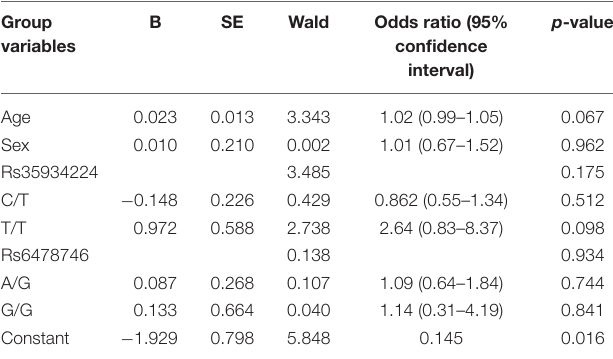
TABLE 3 | Binary logistic regression analysis to determine the effect of age, sex, and polymorphisms on POAG risk. Group variables